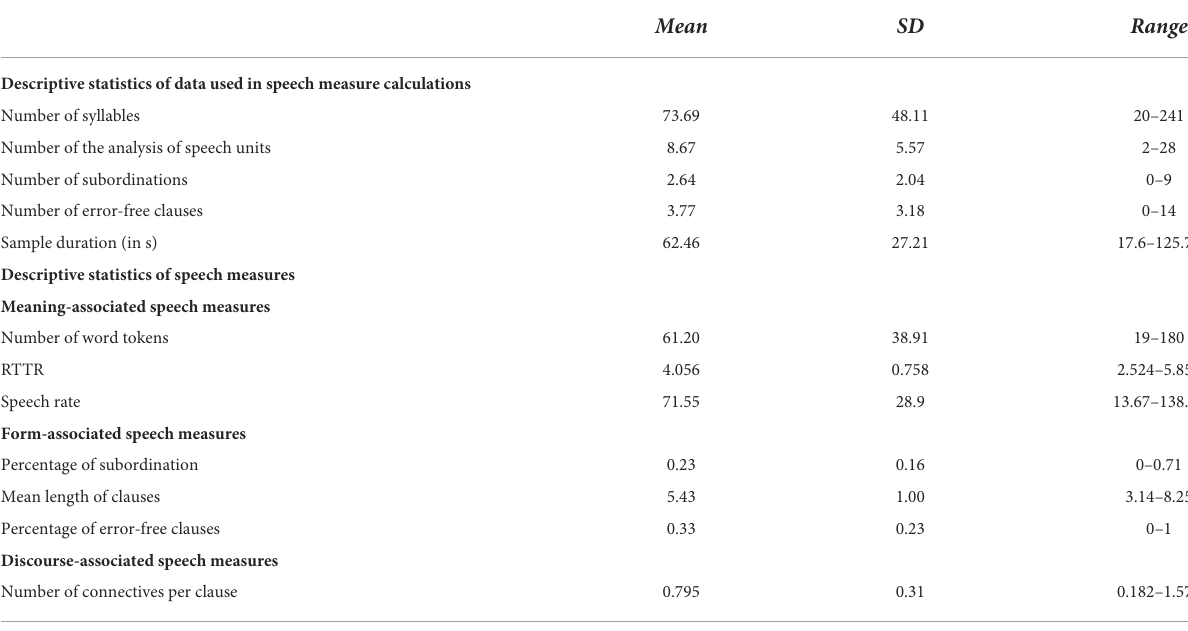
TABLE 2 Descriptive statistics of data used in speech measure calculations and those of speech measures.